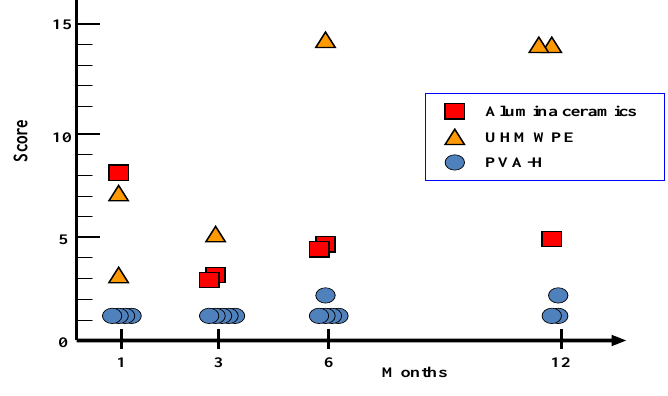
Figure 15. Mankin scores for the changes in acetabular cartilage in each group. Each point represents a single score for a